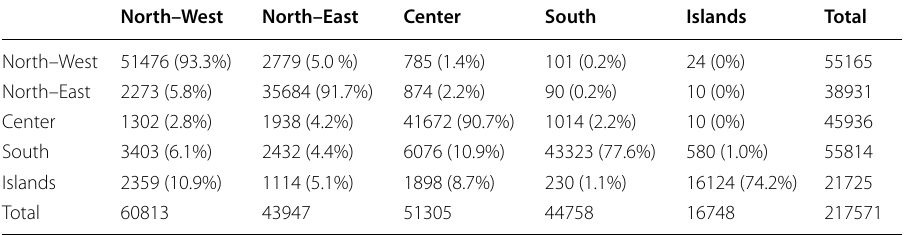
Table 1 Freshmen in 2014–2015 for macro-area of origin (rows) and destination